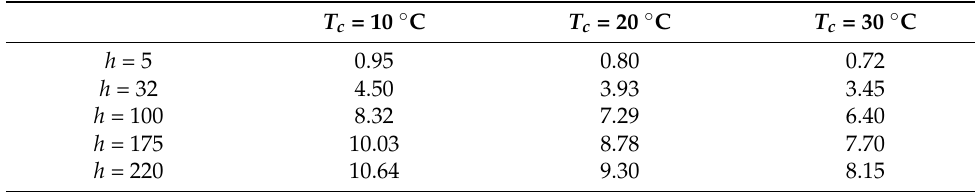
Table 6. Maximum temperature difference between cells (°C).